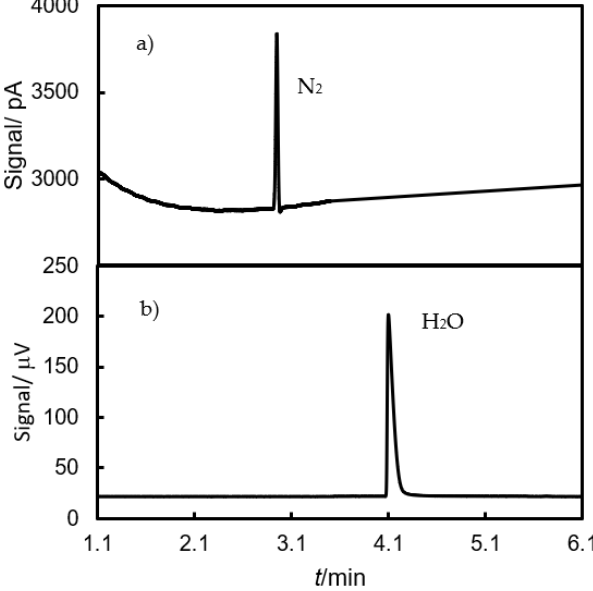
Figure 2. Gas chromatograph recorded on ( a ) PDHID and ( b ) TCD for the liquid phase of the (N 2 + H 2 O) system. HP-Plot-Q column, 0.32 mm OD × 30 m length, film thickness 20 μm. Table 4. For binary and ternary systems, the component that passed through the detector: thermal conductivity detector (TCD) or pulse-discharge helium ionisation detector (PDHID) (D-3-I-HP, Vici) in an Agilent 7890A GC with an HP-PLOT-Q capillary column.